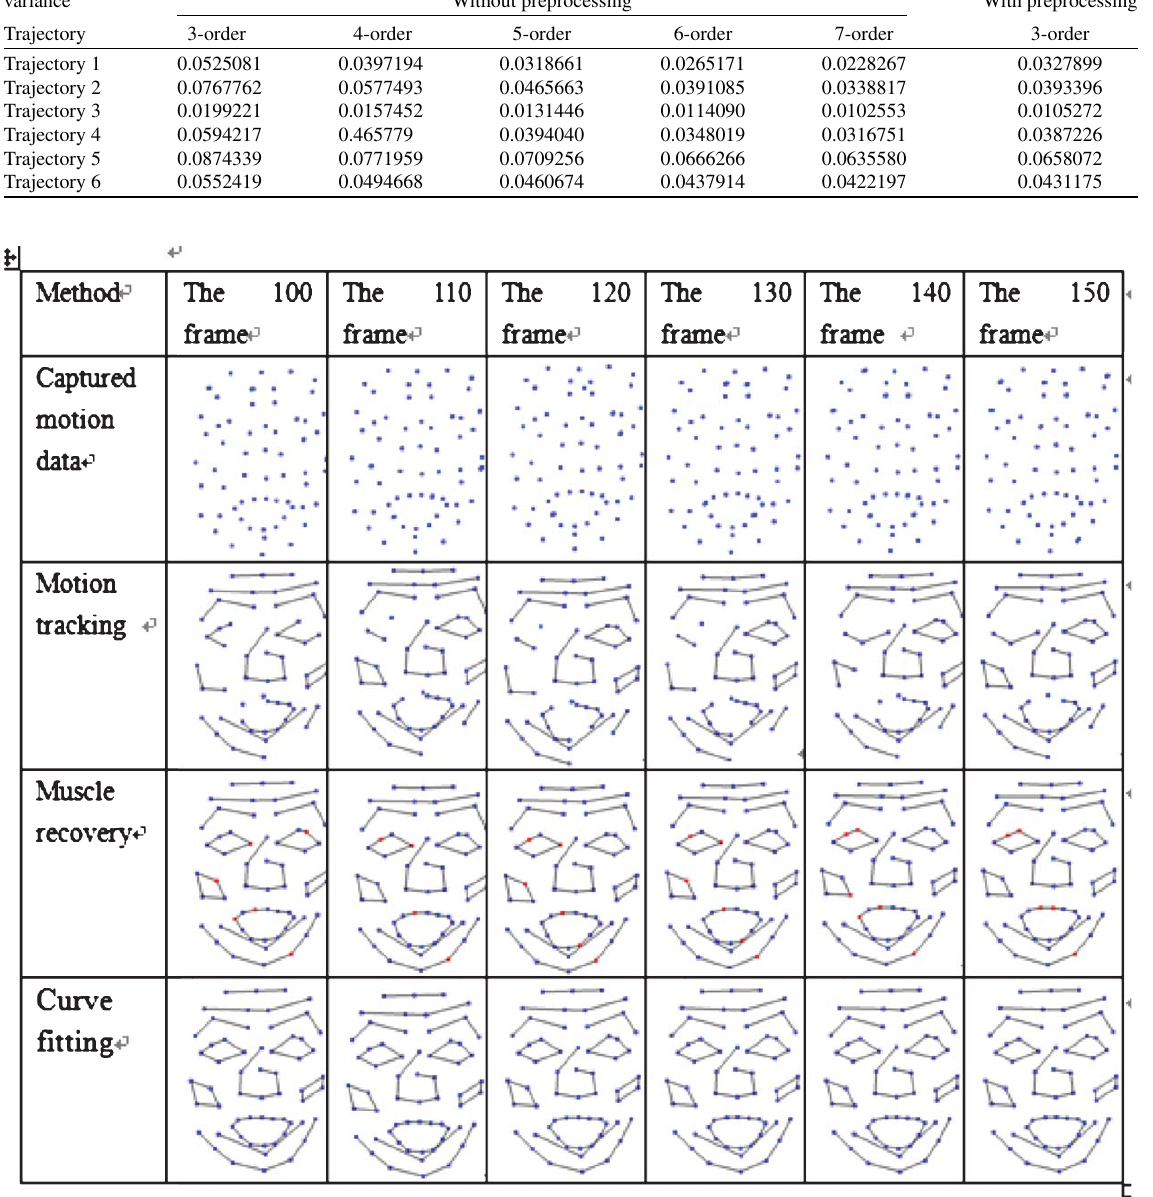
Fig. 9. Frames showing reconstruction using the overall motion data processing